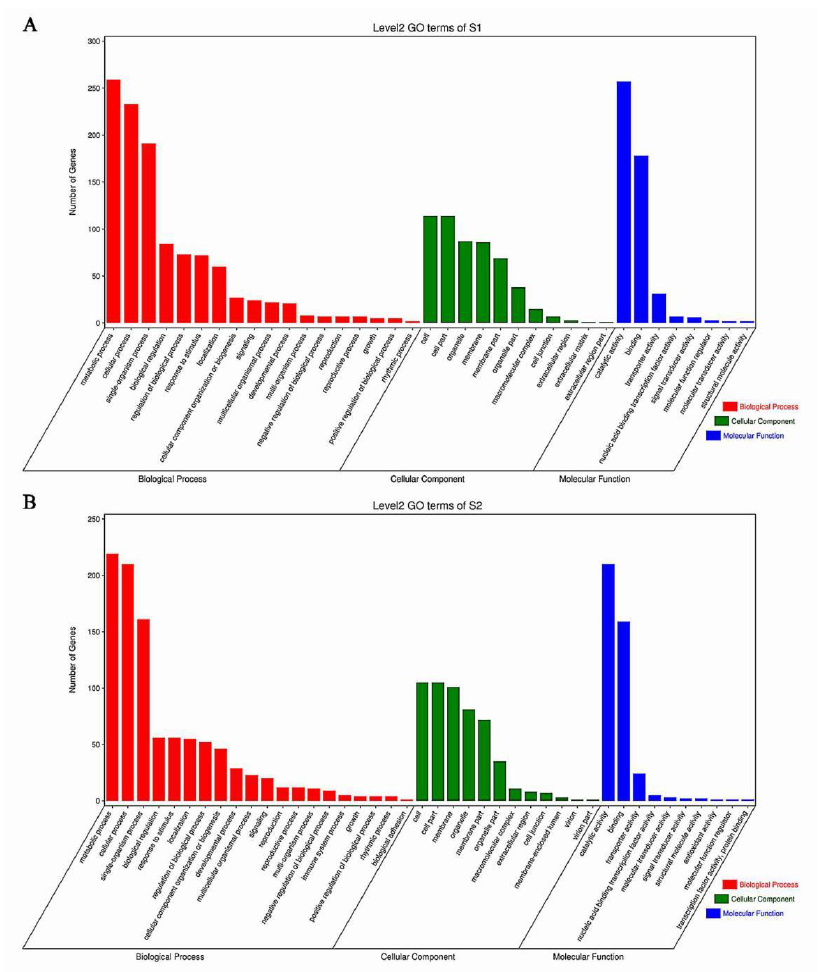
Figure 7. GO annotation analysis of transcriptome. Statistics of the number of DEGs in 3 function categories of GO annotation in sweetpotato for ( A ) 90 d and ( B ) 130 d, respectively. The red, blue, and green columns represent the terms of biological process, cellular component, and molecular function, respectively. The specific metabolic pathways in the regulation of sweetpotato storage root sac- charification at 60 °C were excavated by KEGG enrichment analysis. According to the